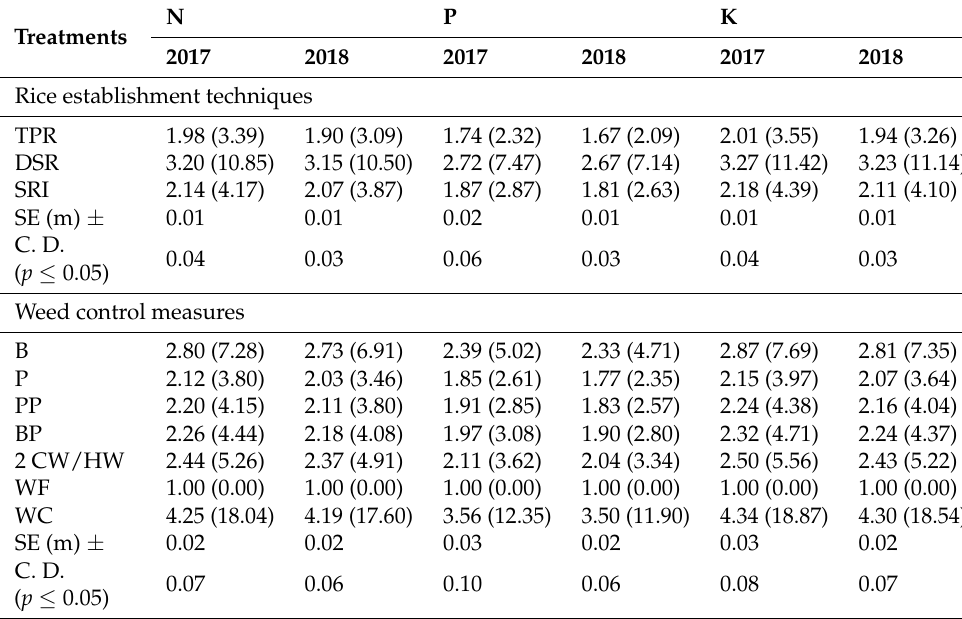
Table 8. Influence of rice establishment techniques and weed control measures on nutrient uptake of weeds (kg ha − 1